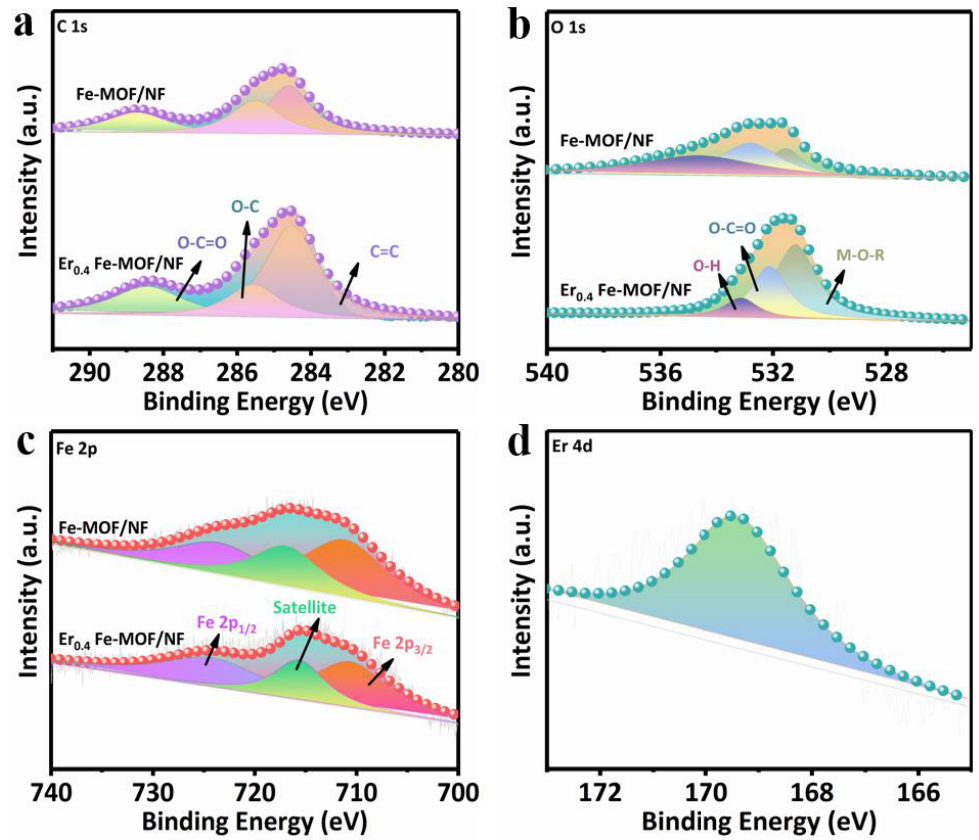
Figure 2. The XPS spectra of C 1s ( a ), O 1s ( b ), Fe 2p ( c ) and Er 4d ( d ) of Er 0 . 4 Fe - MOF/NF and Fe - MOF/NF.